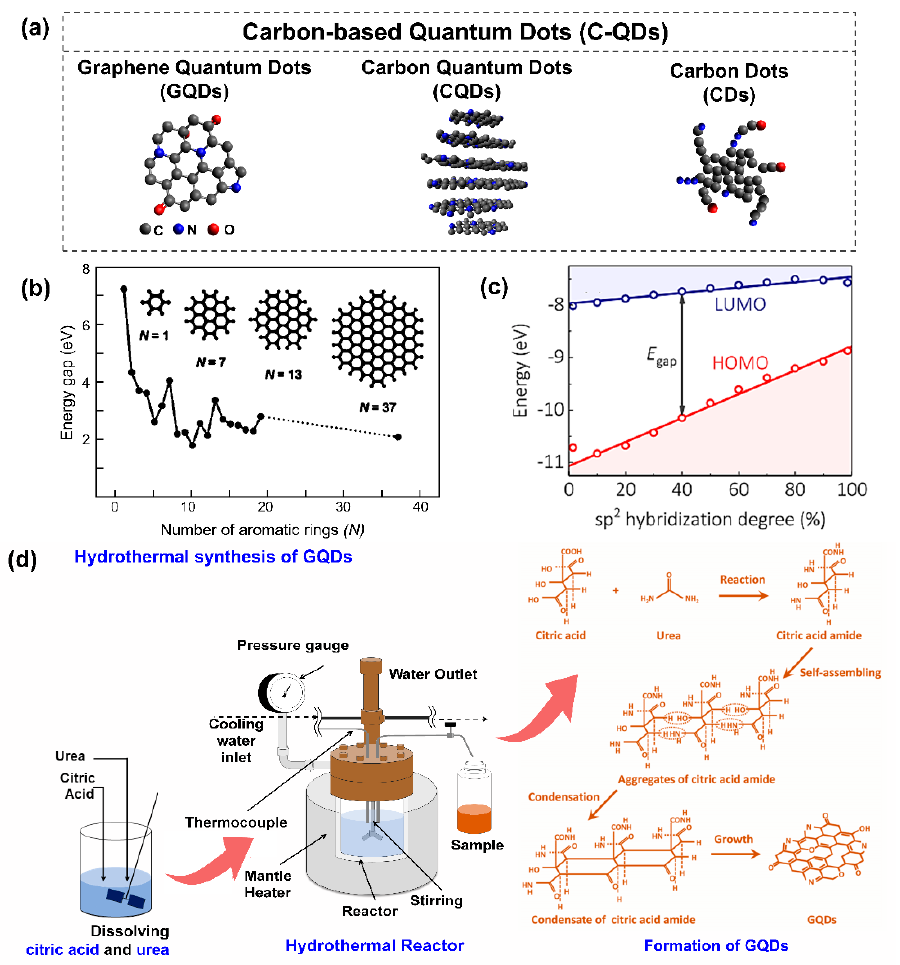
Figure 4. ( a ) Classification illustration for carbon-based quantum dots: adapted from Reference